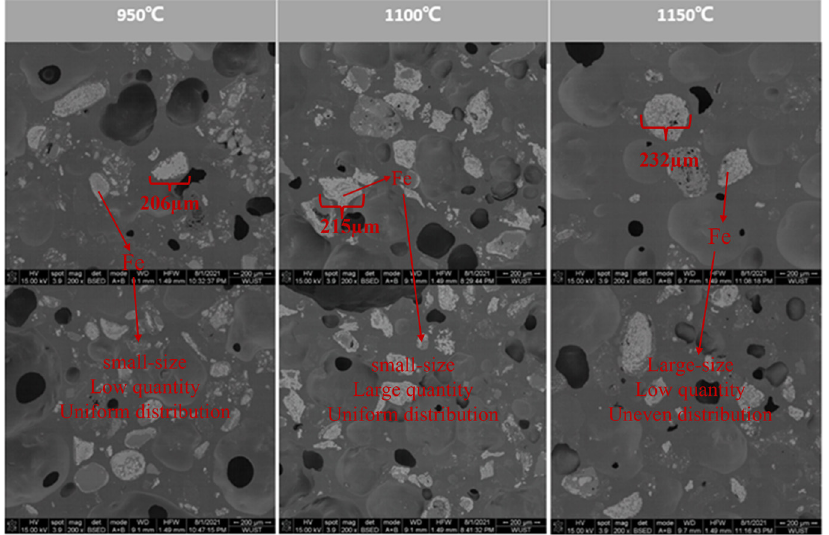
Figure 13. SEM images of iron-carbon micro-electrolytic fi llers at di ff erent sintering temperatures.